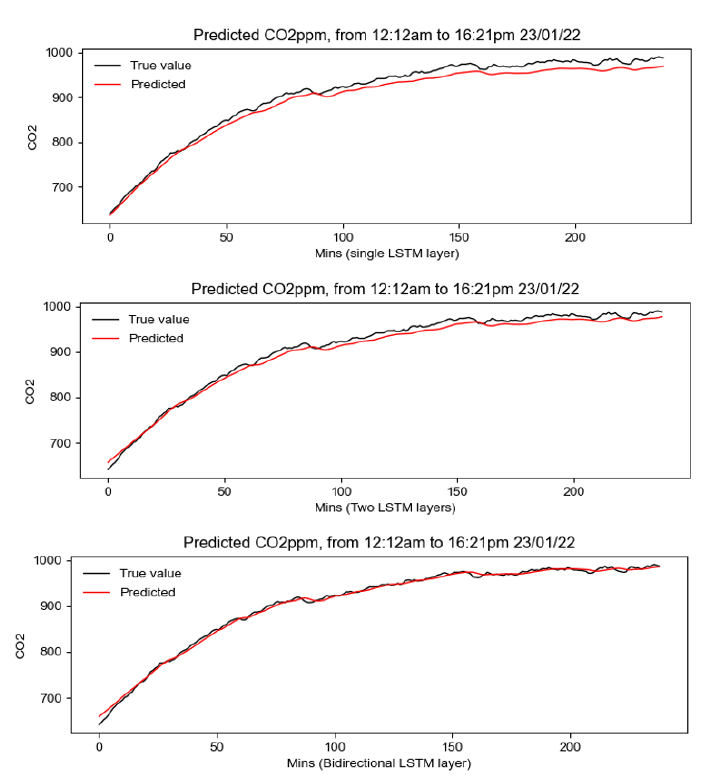
Figure 6. Forecasting CO 2 steady-state concentration